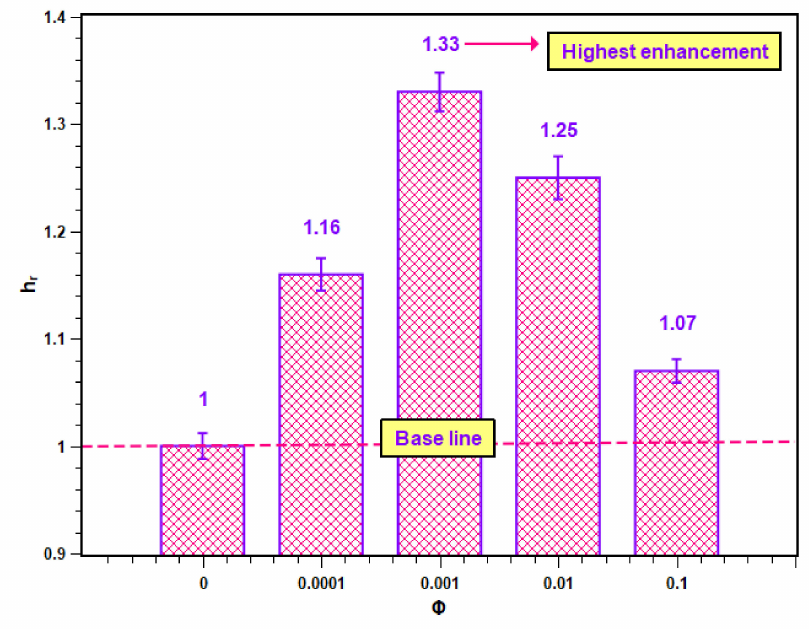
Figure 12. Enhancement in heat transfer coefficient of SiO 2 –water